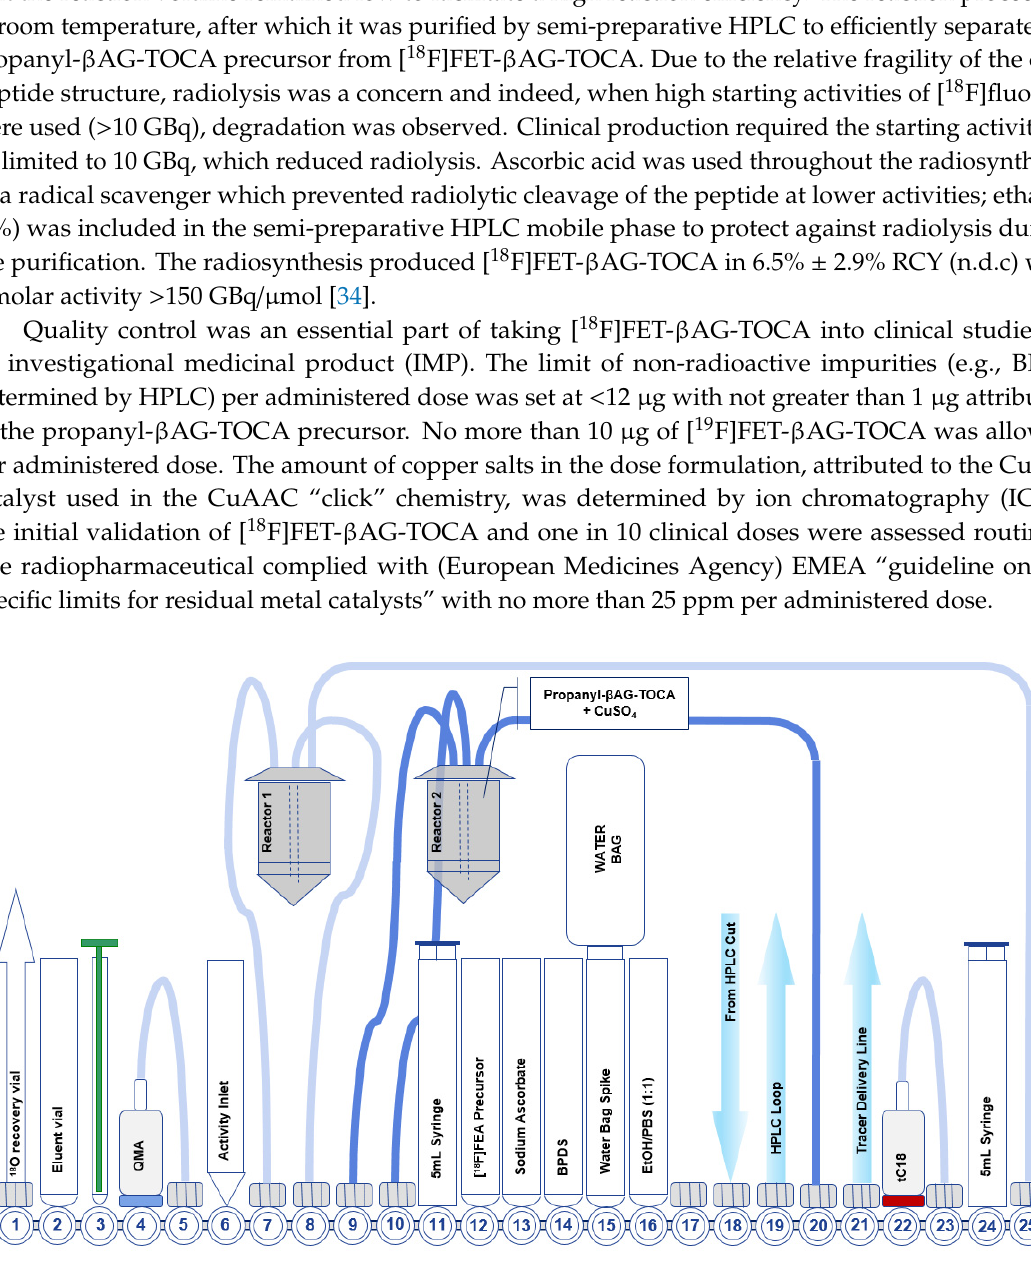
Figure 5. First generation FASTLab™ cassette developed for the GMP radiosynthesis of [ 18 F]FET- β